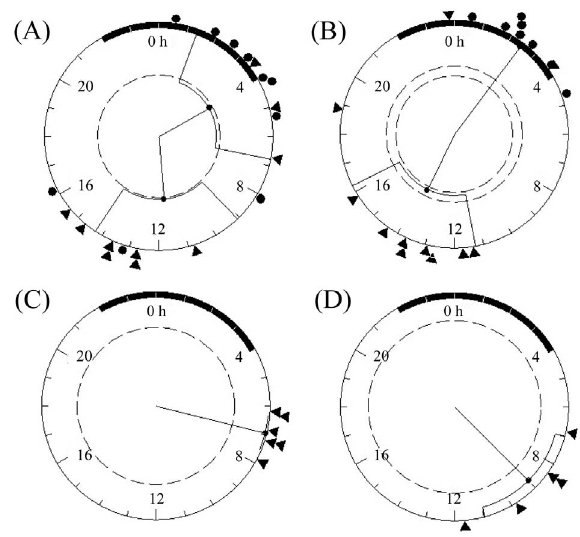
Figure 8. Temporal differences in the main and secondary at- sea activity bouts. Outputs from Rayleigh z-tests used to evaluate clustering of the times of the main and secondary activity bouts (indicated by triangles and circles, respectively) estimated from waveforms of Antarctic prions (A) and blue petrels (B) or of the main bouts only of common diving petrels (C) and South Georgian diving petrels (D). Tick marks from 0–24 represent the hours of the day, the black semicircle depicts night (sunrise at 4:00 GMT, sunset at 22:00 GMT). The dotted circumference defines the threshold value for a significant r vector (p , 0.05). The mean vector for individual values is indicated with confidence intervals.